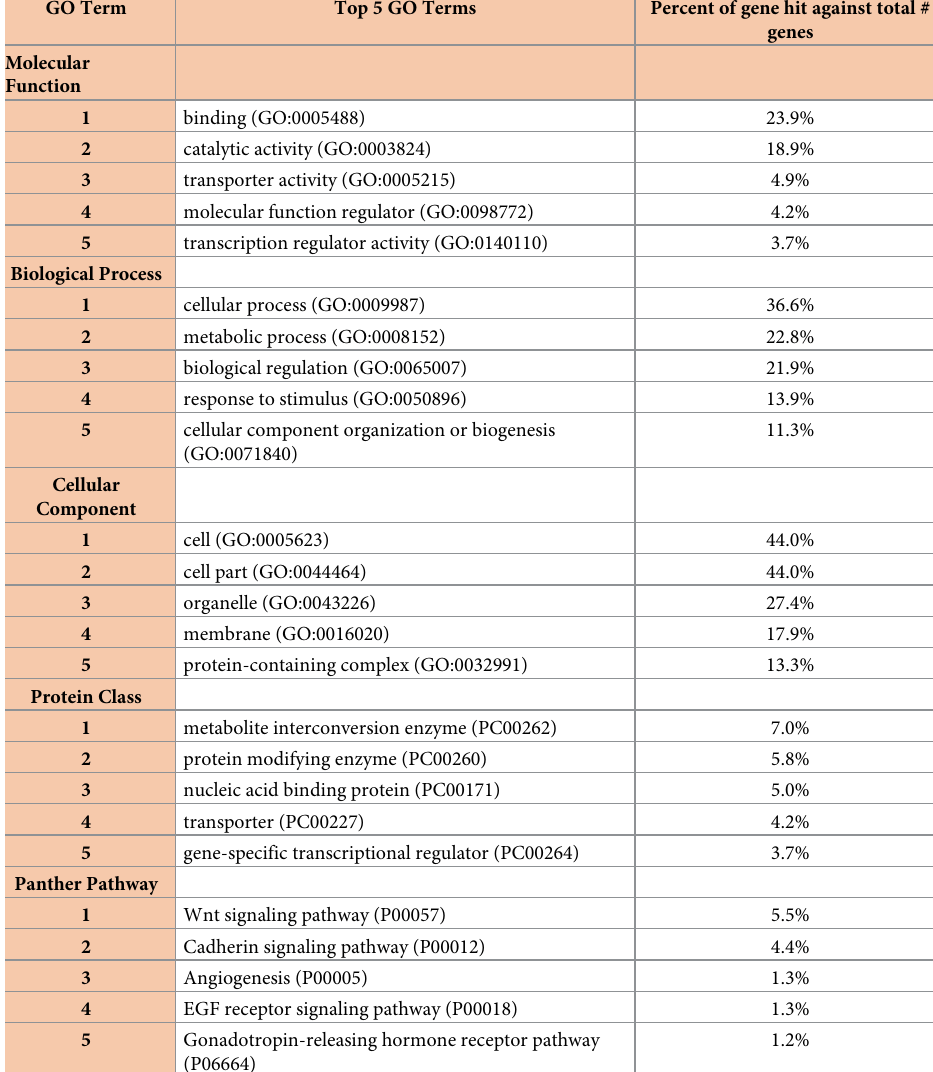
Table 3. The top five GO terms per